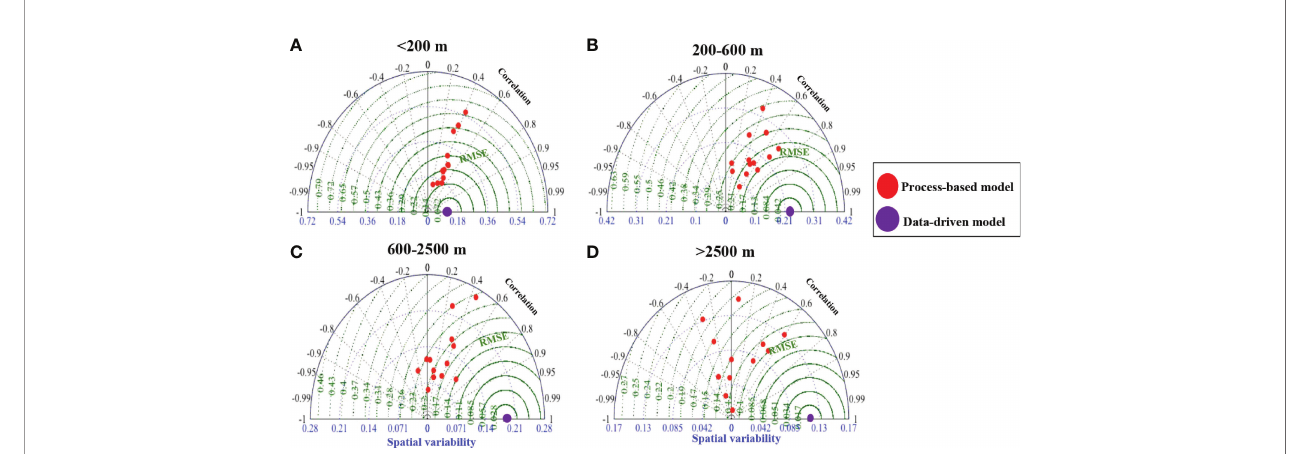
FIGURE 9 | Taylor diagrams comparing global modeled dissolved Fe from thirteen existing process-based models against the random forest data-driven model at the depth different depth intervals (A – D) . The models simulated dFe spatial variability, Pearson correlation coef fi cients and RMSE between process-based and the data-driven models are shown on the blue, black and green axes,